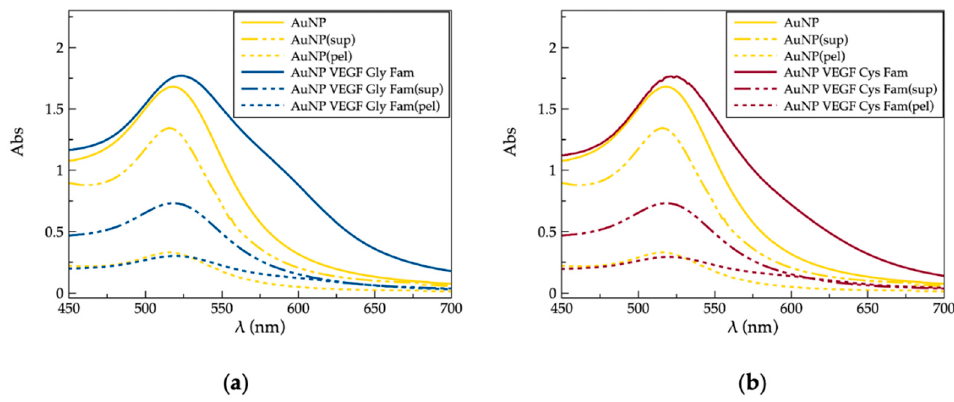
Figure 2. UV-visible spectra of AuNP/VEGF Gly FAM ( a ) and AuNP/VEGF Cys FAM ( b ) dispersions before (solid line) and after (dot line: pellet; dash-dot line: supernatant) centrifugation. The spectra for bare AuNP are shown for comparison.